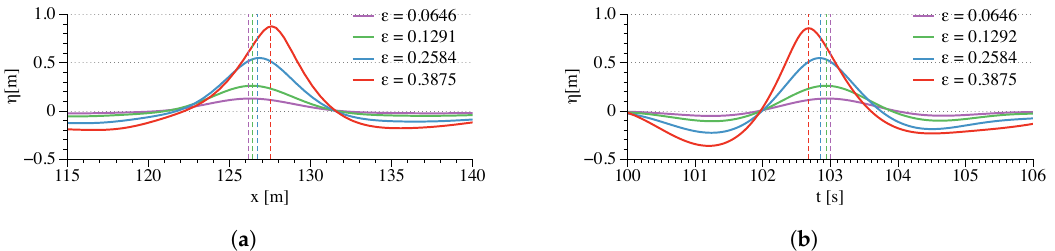
Figure 15. Comparison of the wave surface elevations at the designated focusing time and location with four different wave steepnesses, ( a ) the wave profiles in the longitudinal direction at t = 103 s, ( b ) the time series at x = 126.21 m.